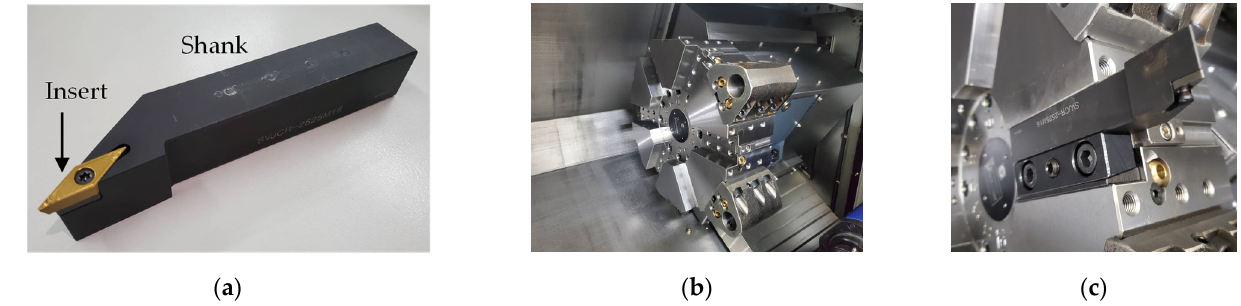
Figure 2. The proposed smart tool holder is designed for: ( a ) the standard turning tool, model: SVJCR-2525M16; ( b ) the tool turret of the Tongtai TS-85 CNC bedroom lathe; and ( c ) the turning tool clamped on the tool turret. Table 1. The specification of the model SVJCR-2525M16 turning tool and the model VCMT160404HQ insert. Model SVJCR-2525M16 turning tool